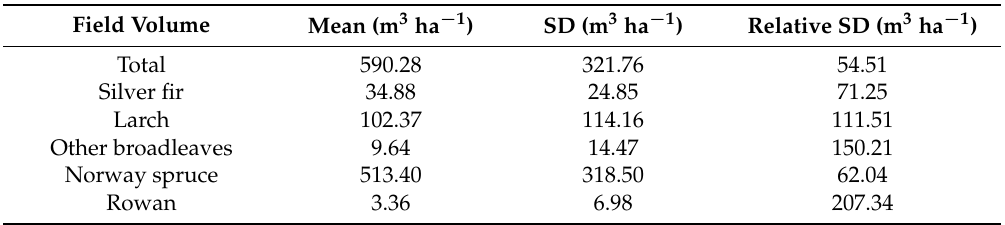
Table 2. Statistics of the field-observed total and species-specific volumes for five species classes at the plot